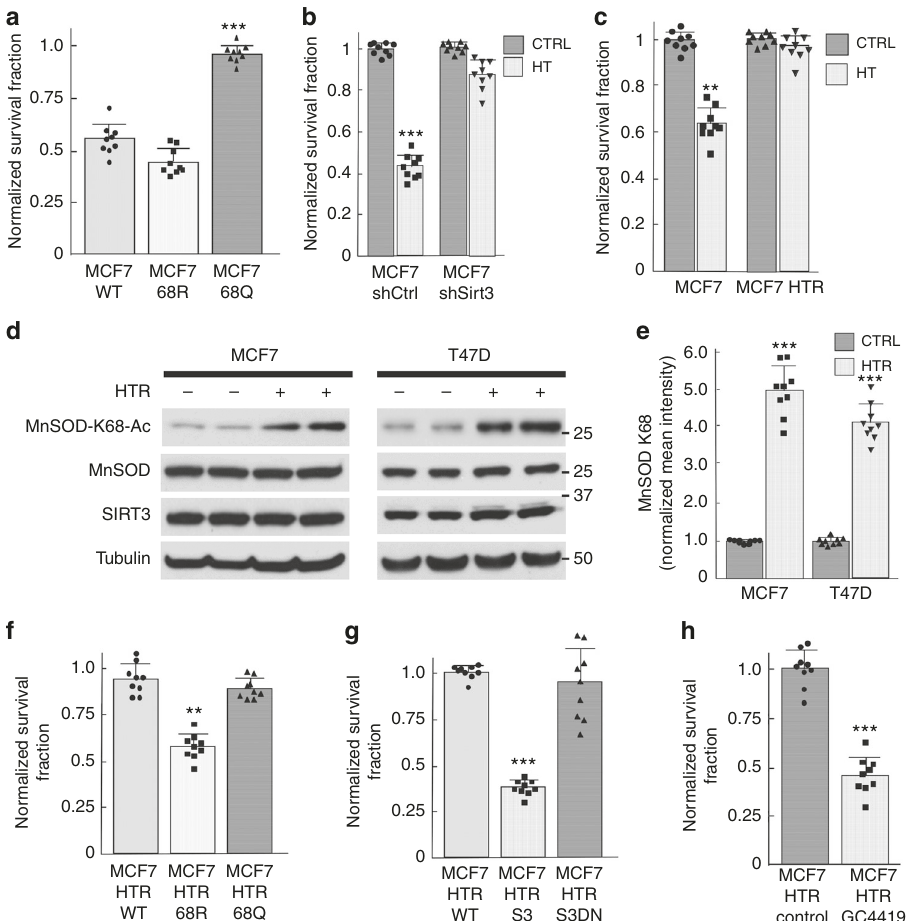
Fig. 6 Hydroxy-Tam-resistant breast cancer cells exhibit a MnSOD-K68-Ac signature. a – c Clonogenic cell survival experiments for: a MCF7-MnSOD WT , MCF7-MnSOD K68R , and MCF7-MnSOD K68Q cells; b MCF7-shCtrl and MCF7-shSIRT3 cells; and c MCF and MCF7-HTR cells, with and without exposure to 1 μ M hydroxy-Tam for 120 h (HT), as measured by cytotoxicity. d , e MCF7 and MCF7-HTR, as well as T47D and T47D-HTR cell lysates, immunoblotted for MnSOD-K68-Ac, MnSOD, SIRT3, and actin; and e Immunoreactive protein levels were quanti fi ed. f – h Clonogenic cell survival experiments for MCF7-HTR cells. f Cells expressing MnSOD WT , MnSOD K68Q , or MnSOD K68R were treated with 1 μ M hydroxy-Tam for 120 h. g Cells expressing SIRT3 WT or SIRT3 DN (S3DN; deacetylation-null SIRT3 gene) were treated with 1 μ M hydroxy-Tam. h Cells were treated with 5 μ M GC4419 for 5 days. All experiments were done in triplicate. Error bars represent ± 1 SEM. ** p < 0.01, and *** p < 0.001. Three groups were analyzed via a one-way ANOVA statistical analysis with Tukey ’ s post-analysis, and two groups were analyzed by a t